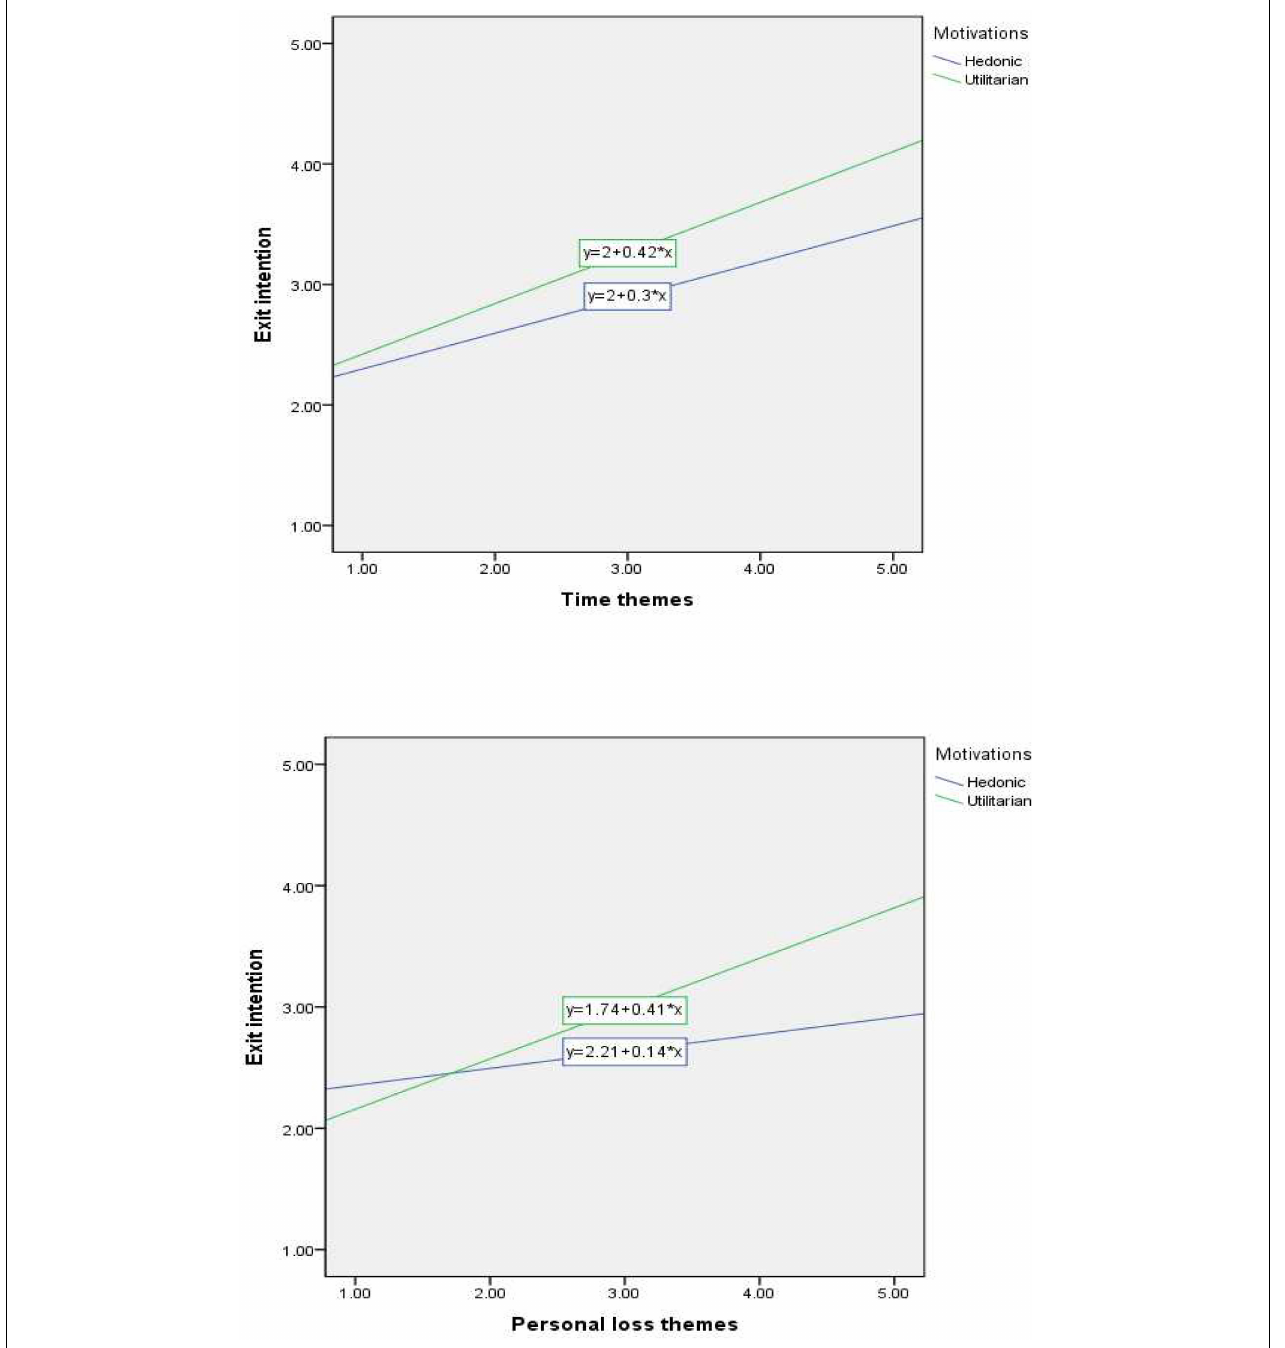
FIGURE 2 | (A) The moderating role of hedonic/utilitarian motivations (H5: Upkeep). (B) The moderating role of hedonic/utilitarian motivations (H6: Benefit). (C) The moderating role of hedonic/utilitarian motivations (H7: Time). (D) The moderating role of hedonic/utilitarian motivations (H8: Personal